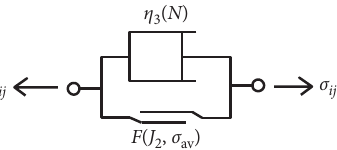
Figure 6: One-dimensional NVPFM of the rock [42].